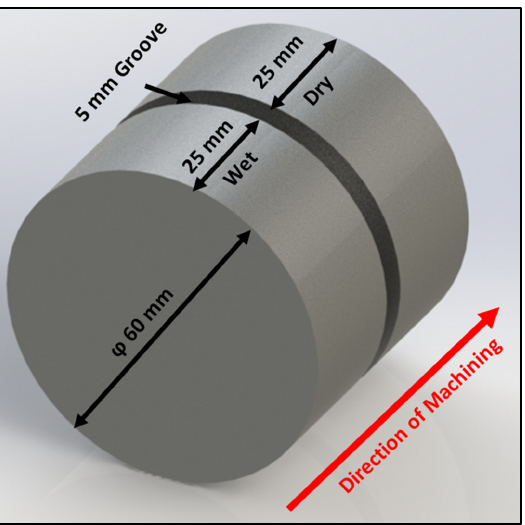
Figure 16. Validation of dimensional accuracy of test specimen’s dimensions. Table 8. Effect of dry and wet conditions on dimensional tolerances.